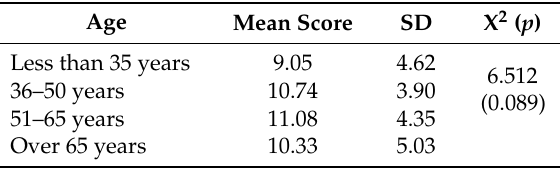
Table 4. Ratings in HLS-EU-Q16 by age